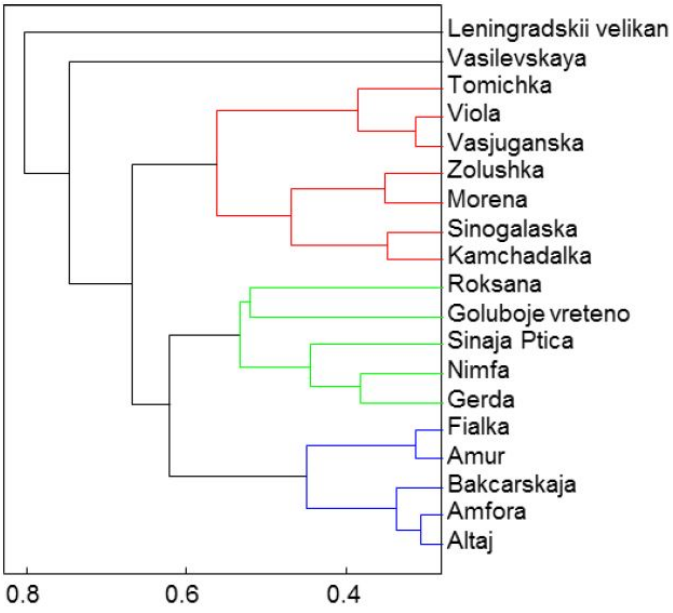
Figure 4. The cluster analysis of polyphenolic compounds represented by five principal